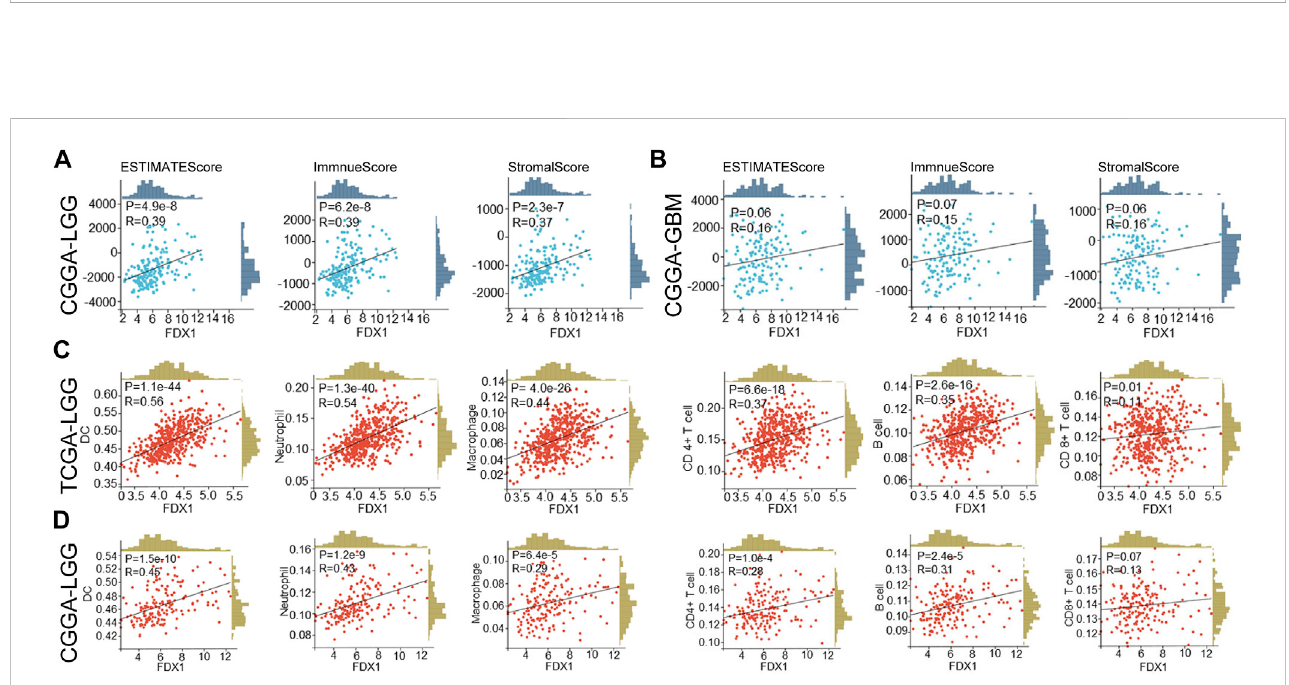
FIGURE 10 FDX1 was correlated to immune cells in fi ltration in LGG based on TCGA and CGGA databases and StromalScore, ImmuneScore, and ESTIMATEScore in CGGA database. (A) The correlation between FDX1 expression and StromalScore, ImmuneScore, and ESTIMATEScore in CGGA-LGG database. (B) The correlation between FDX1 expression and StromalScore, ImmuneScore, and ESTIMATEScore in CGGA-GBM database. (C) The correlation between FDX1 expression and immune cells in fi ltration in TCGA-LGG database. (D) The correlation between FDX1 expression and immune cells in fi ltration in CGGA-LGG database. [Immune cells: B cell, CD4 + T cell, CD8 + T cell, neutrophil, macrophage, and dendritic cell (DC), all correlation analyses were shown by Pearson coef fi cient, p < 0.05 was considered signi fi cant.]